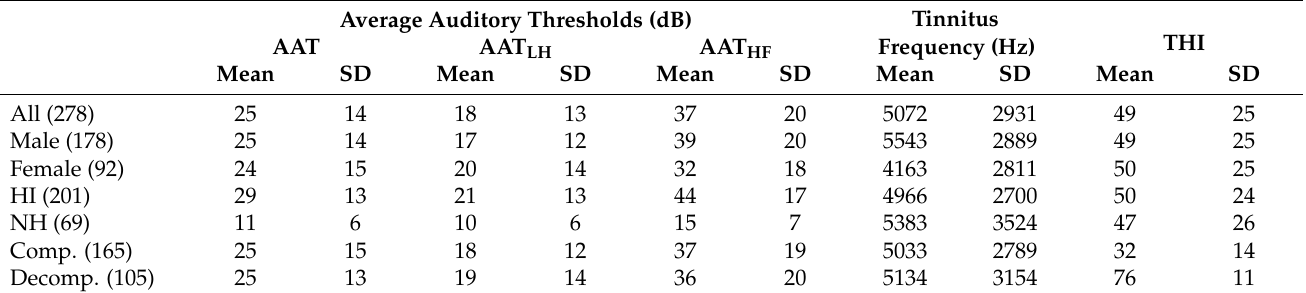
Table 4. Hearing levels, tinnitus frequency, and tinnitus severity of